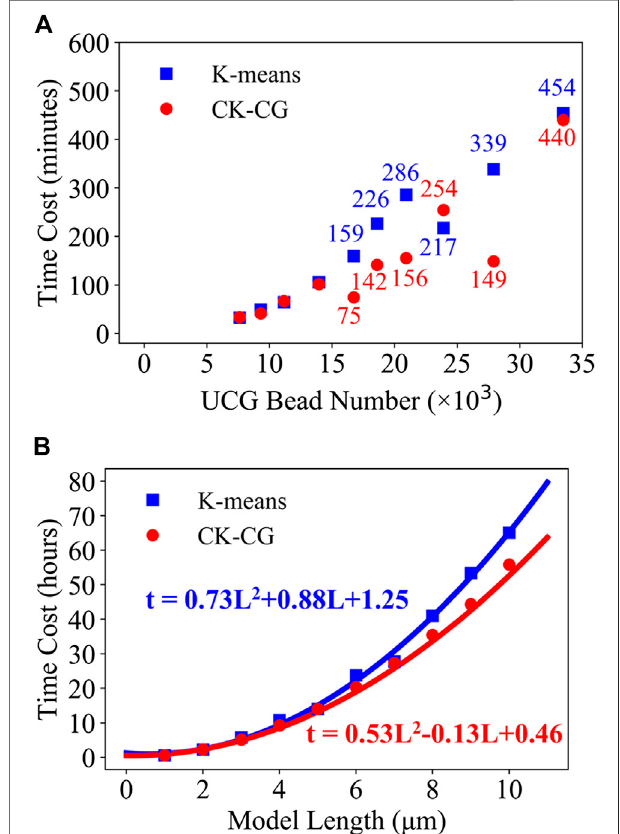
FIGURE 3 | The time cost for building models with (A) different numbers of UCG beads and (B) different lengths. The blue squares and red dots represent the results from the K-means and CK-CG methods, respectively. The integers in plot (A) denote the exact time cost in minutes. In the plot (b), the set of data are fi tted with two quadratic curves,